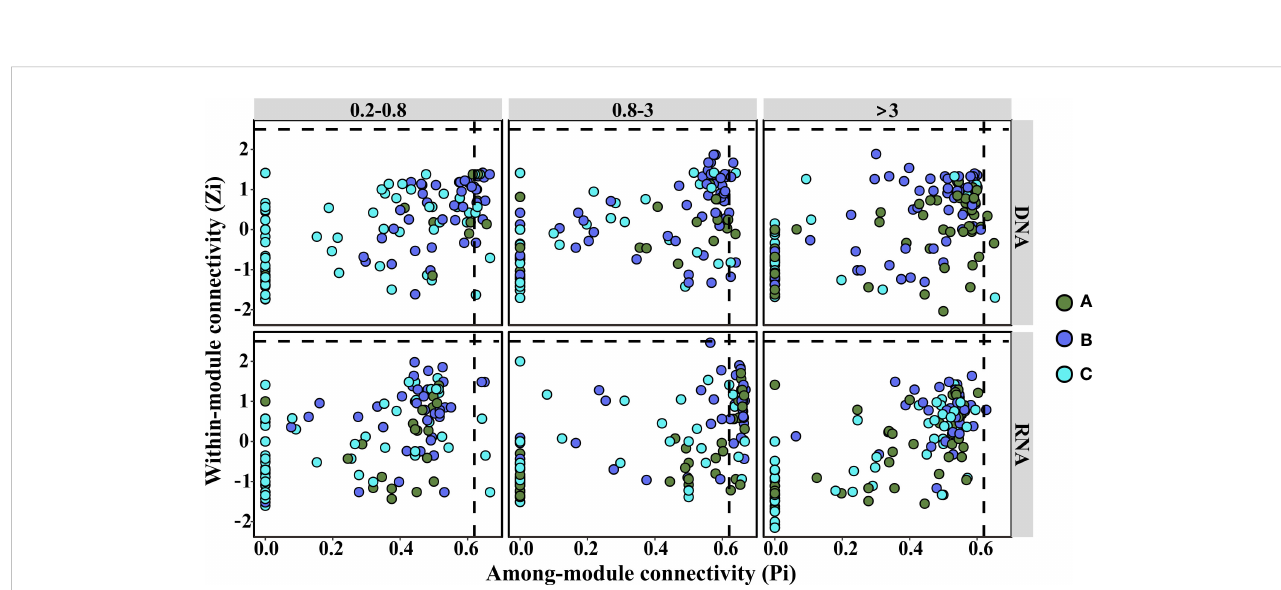
FIGURE 4 Zi-Pi plot showing the distribution of groups based on their topological roles. Dots represent bacterial groups with different trends over the incubation period. (A) Increasing (p < 0.05); (B) decreasing (p < 0.05); (C) not signi fi cant (p > 0.05). The horizontal dashed line represented a Zi of 2.5, while the vertical dashed line represented a Pi of 0.62.